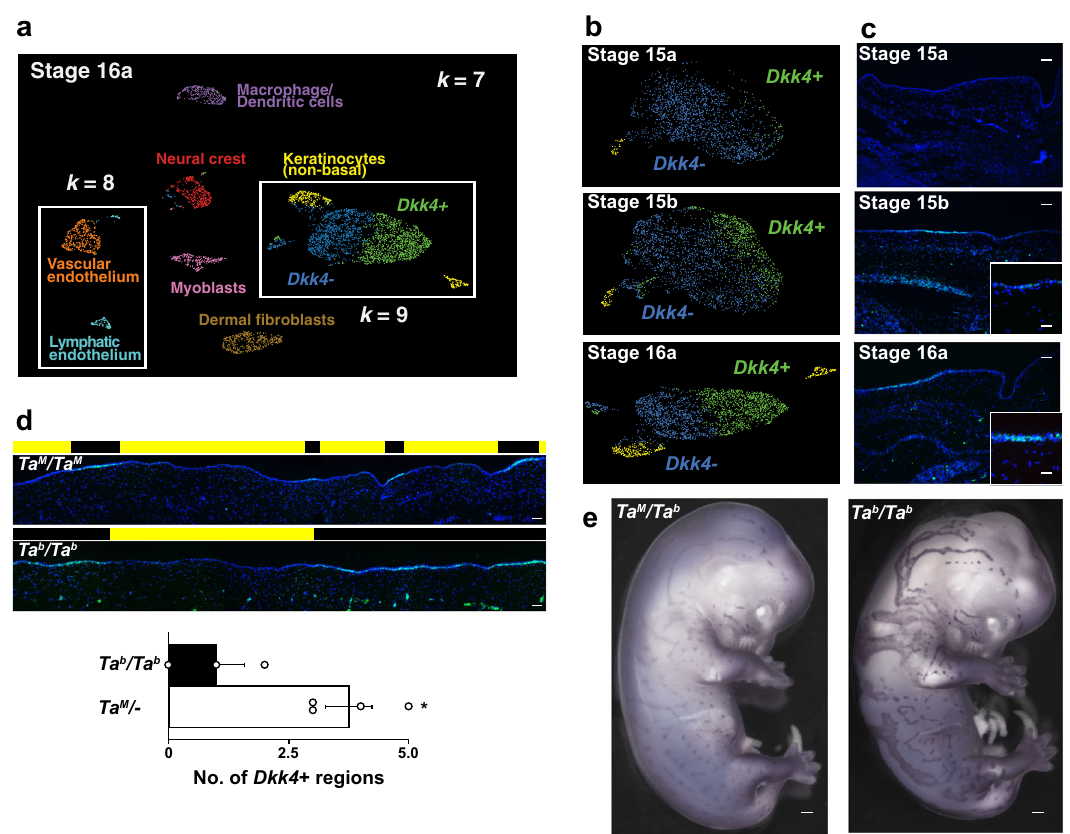
Fig. 2 Pattern of gene expression in fetal cat skin determined by single-cell RNA sequencing and in situ hybridization. a Skin cells at stage 16a grouped by their patterns of gene expression (UMAP visualization) with populations colored according to k -means clustering from k = 7 to k = 9 as described in the text. Keratinocytes cluster as non-basal (yellow) and basal populations at k = 7, with the latter split into subpopulations distinguished by high (green) and low (blue) Dkk4 expression at k = 9. Subpopulations of endothelium appear at k = 8 (orange, cyan). b Supervised (top and middle panels; stage 15a and 15b) and k -means (bottom panel, stage 16a) clustering at sequential developmental stages delineate non-basal (yellow) and two basal keratinocyte populations, Dkk4 -positive (green) and Dkk4 -negative (blue). c Dkk4 expression (green) in fetal cat skin at corresponding stages (DAPI, blue; high power image, inset). In situ hybridizations were carried out independently on three or more embryos at each developmental stage with similar results. d Dkk4 expression (green) in sections of stage 16 Ta M /Ta M and Ta b /Ta b embryonic cat skin (DAPI, blue). Black and yellow blocks mark thick and thin regions, respectively. The number of Dkk4 -positive regions (mean + / − sem) in 3.6 mm of Stage 16 Ta M / − and Ta b /Ta b embryonic cat skin from sections ( n = 3 – 4 regions from at least two animals of each genotype; two-tail t-test, * P = 0.019). e Dkk4 expression (purple) in stage 16 Ta M /Ta b and Ta b /Ta b cat embryos. Whole-mount in situ hybridization was carried out on two Ta M /Ta b and Ta b /Ta b embryo sibs; three additional Ta M / − embryos showed similar